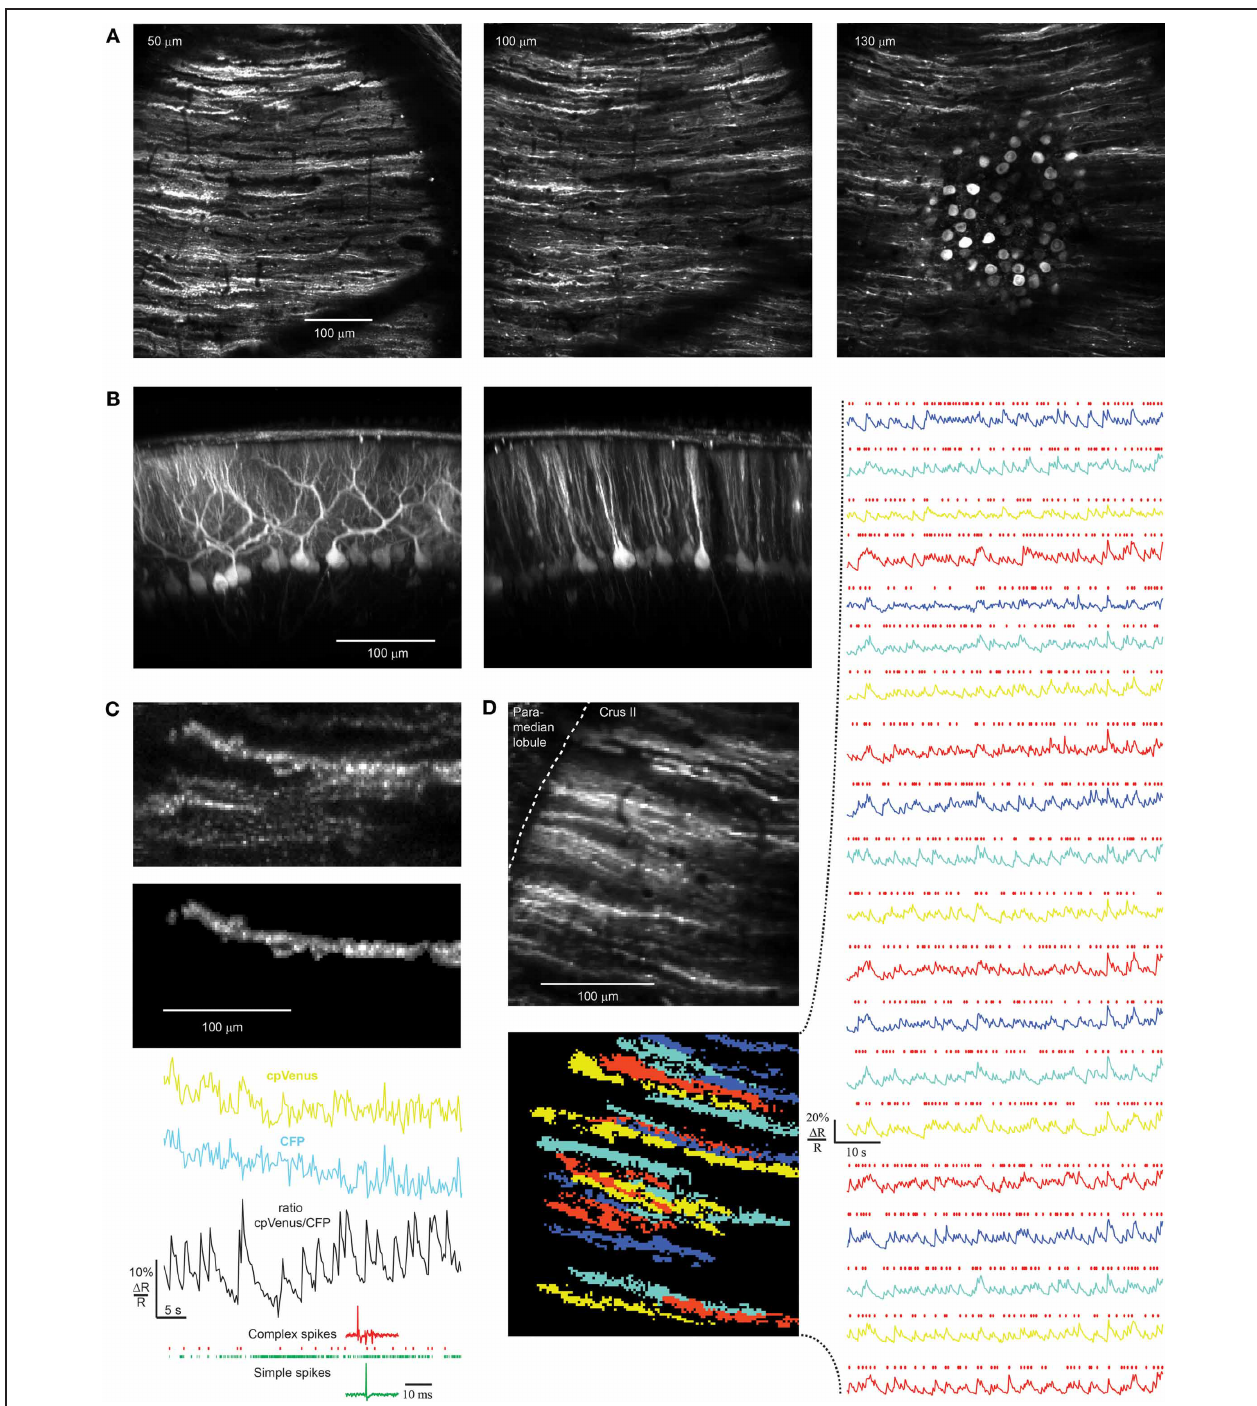
FIGURE 5 | rAAV-hSYN-tTA and rAAV-P tet bi-D3cpv labeling of PCs and recording in awake mice. (A) Near-ubiquitous labeling of PCs within a field of view. (B) Reconstruction of the parasagittal orientation of PCs. (C) Transients representing PC complex spikes as shown by simultaneous electrical (bottom) and ratiometric optical recording (black trace). In the corresponding raw traces of CFP and cpVenus the functional signals are hidden in movement artifacts (mask of PC dendrite: top). The dendrite bleaches in both channels 12% during the 50s of functional imaging.